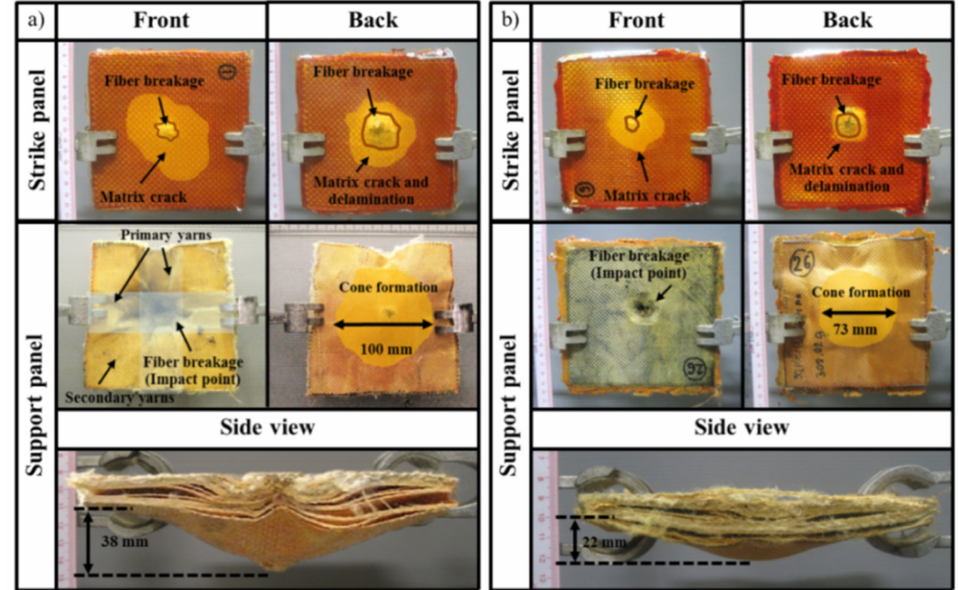
Figure 7. Ballistic-impact response of the specimens that consisted of a strike panel of S-glass fabric that was reinforced with poly(BA-a) and a support panel of an aramid fabric that was reinforced with a poly(BA-a/PU) composite ( a ) without MWCNTs or ( b ) containing 0.3 wt% of MWCNTs after being impacted by a 7.62 × 51 mm 2 projectile.